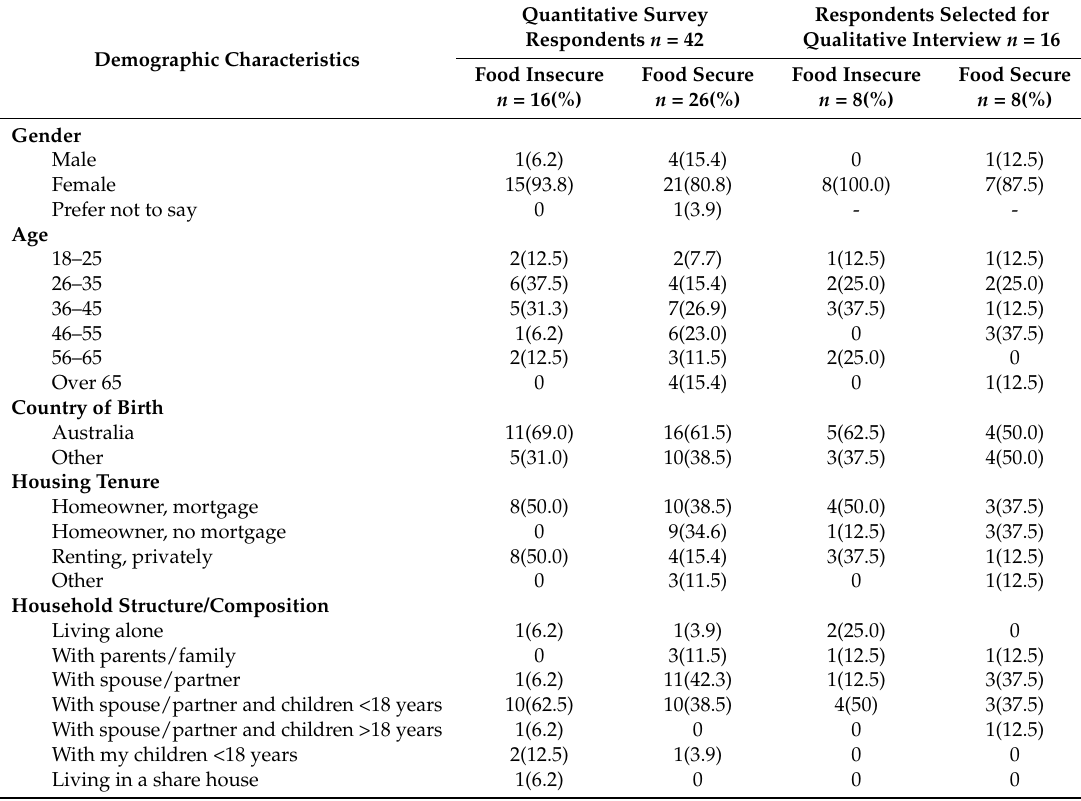
Table 1. Characteristics of low-to-middle income survey respondents ( n = 42) and in-depth interview participants ( n = 16) according to food security